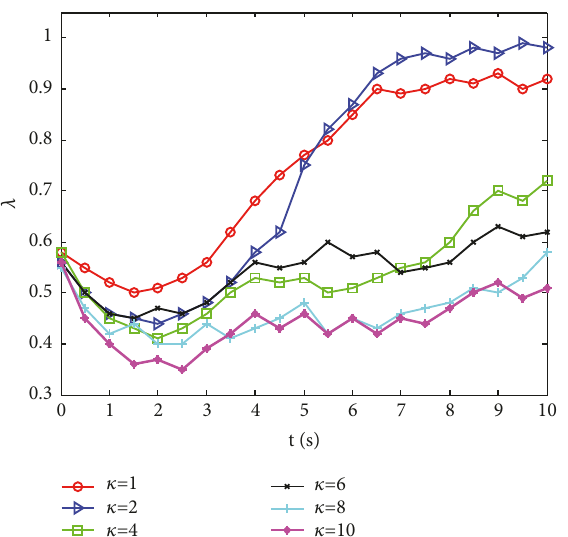
Figure 12: The polarization index of flocking system with different 𝛽 .